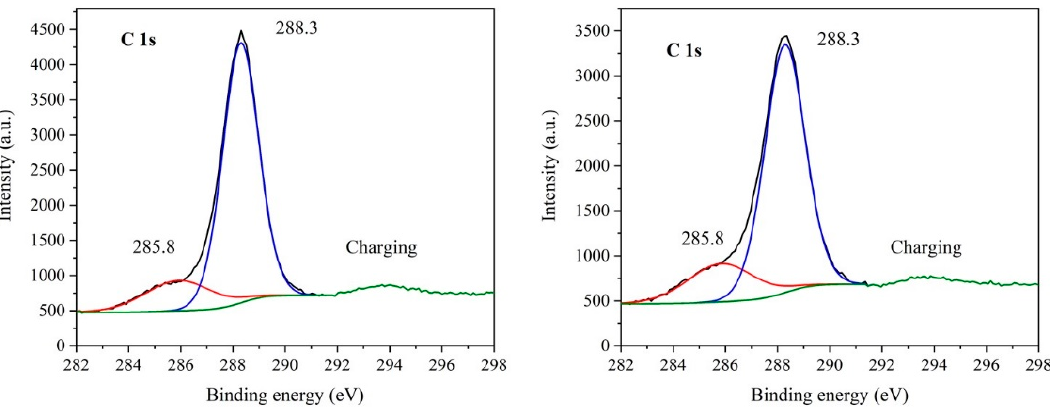
Figure 6. XPS spectra of C 1s of Ex3 ( left ) and Ex3 30 % H 2 O 2 nanomaterials ( right ).